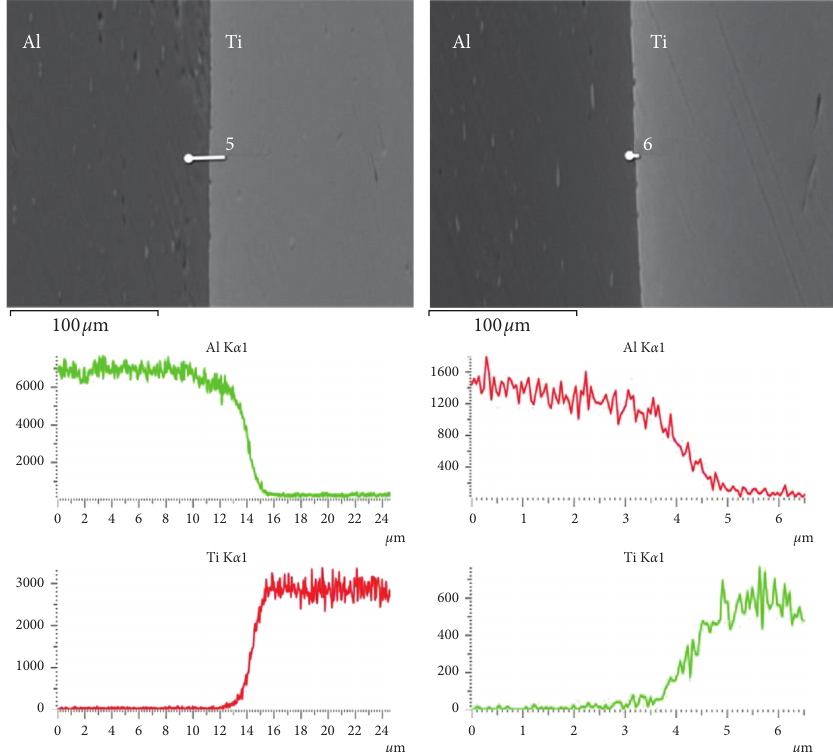
Figure 12: The morphology and the energy spectrum of S4.